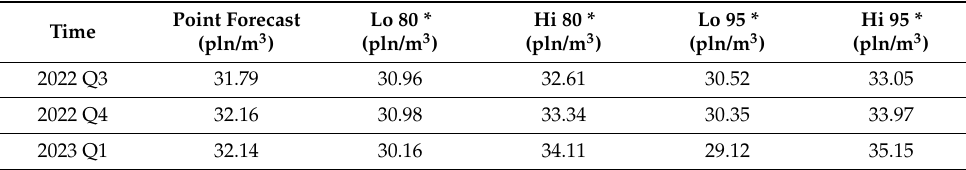
* estimated value 80% and 95% confidence